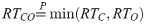
Behavioral refutation of a spurious prediction RTCO=Pmin(RTC,RTO) based on the incorrect assumption that V1 lacks neurons tuned simultaneously to both orientation and color.The graphs show distributions (in discrete time bins) of RT
O, RT
C, and RT
CO (and the average and the standard deviation of RT
CO) of a particular observer SA in searches of the singletons. Experimental data are shown in red, the prediction is in blue. The predicted and actual distributions of RT
CO are significantly different from each other, indicated by a p < 0.002 in the bottom plot.